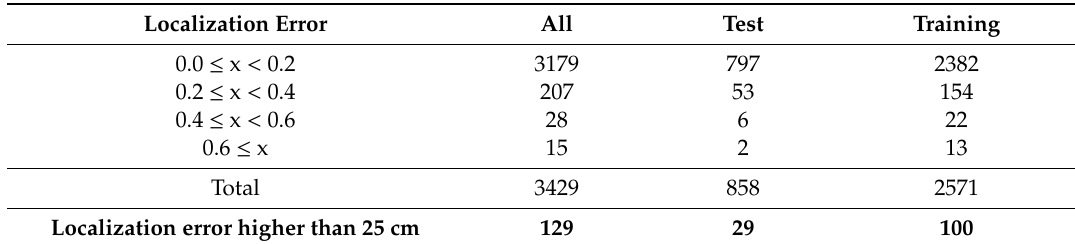
Table 11. Distribution of actual localization error, by count (Model